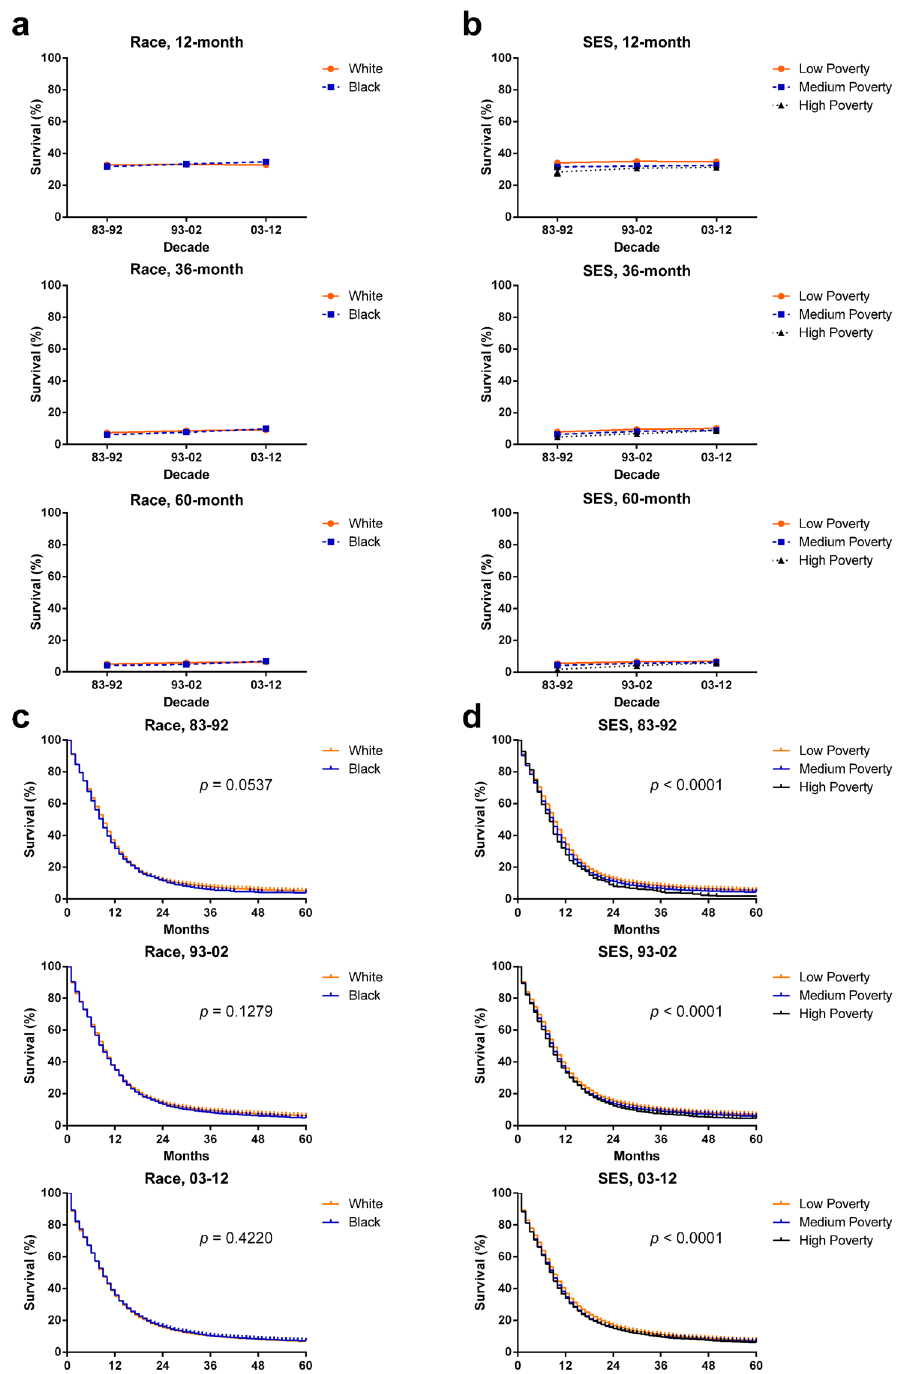
Figure 4. 12-month, 36-month and 60-month relative survival rates by race ( a ) and SES/county-level poverty rates ( b ) and Kaplan-Meier survival analyses according to race ( c ) and SES/county-level poverty rates ( d ) for patients with SCLC at 18 SEER sites from 1983 to